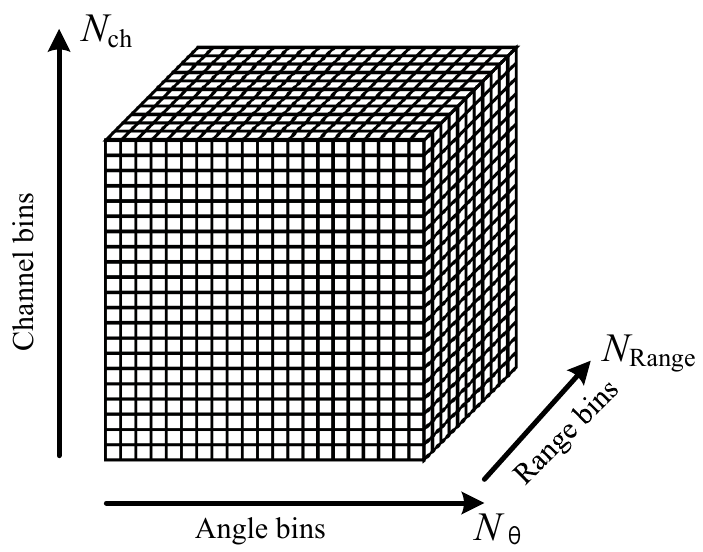
Figure 2. The datacube of circular array synthetic aperture sonar.